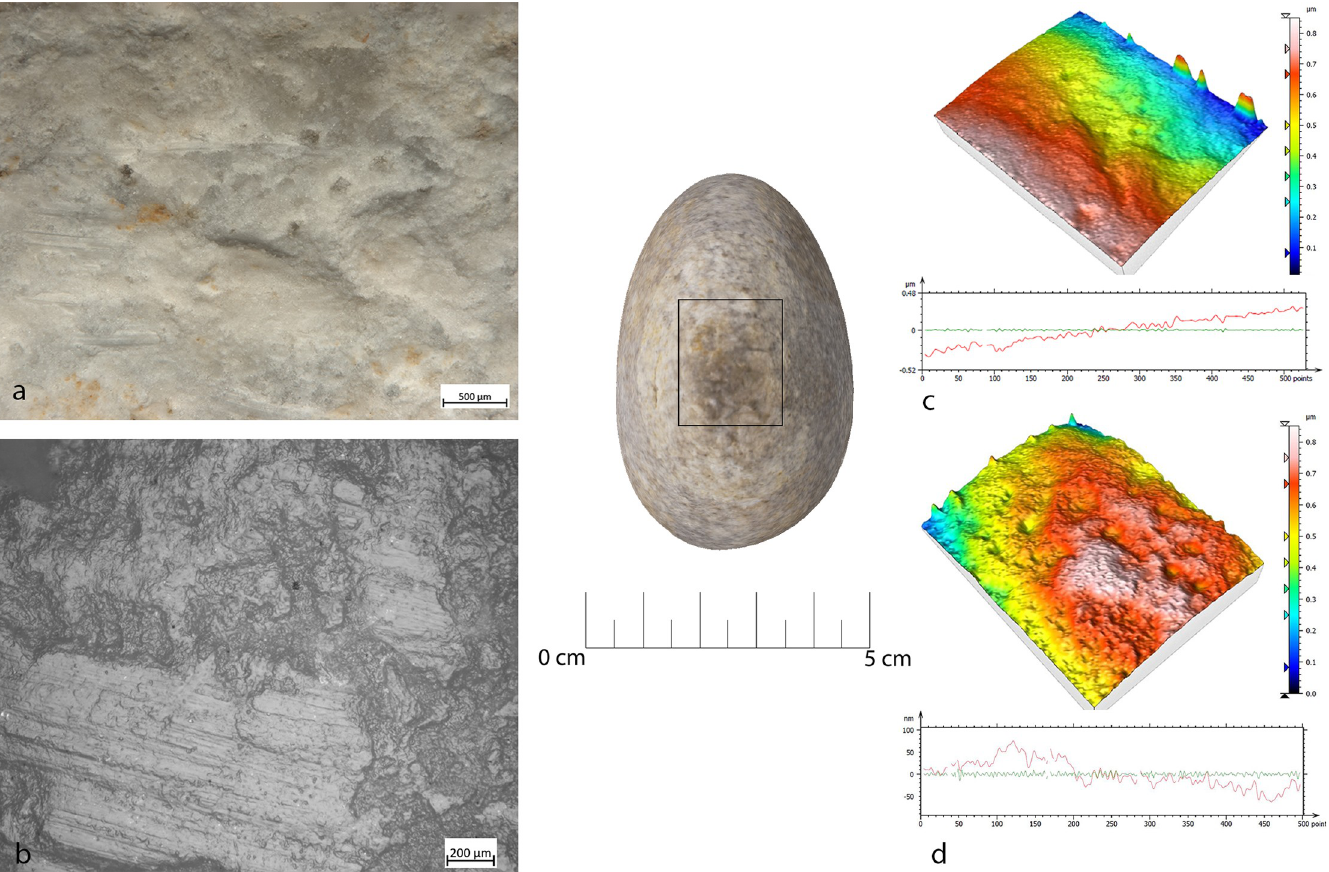
Fig 8. FBR-2 use wear on an experimental replica used in the configuration of the striking platform of the core. (a) Macro-traces (30x) highlight the presence of overlapping pits with sub-oval morphology, located all around the marginal perimeter of the object; (b) micro-traces (200x) are extended onto the top of the grains, with smooth texture, flat topography, striation with the same orientation, and concentrated-separated distribution; (c) 3D microtopography of the unused surface and profile; (d) 3D microtopography of the used surface and